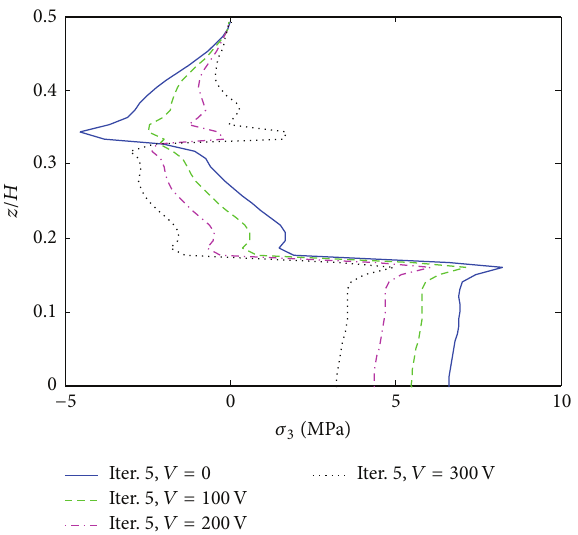
Figure 6: 𝜎 3 distribution of [PZT/0 4 /90 4 ]s laminate at the free edge, under 0.1% uniaxial strain.